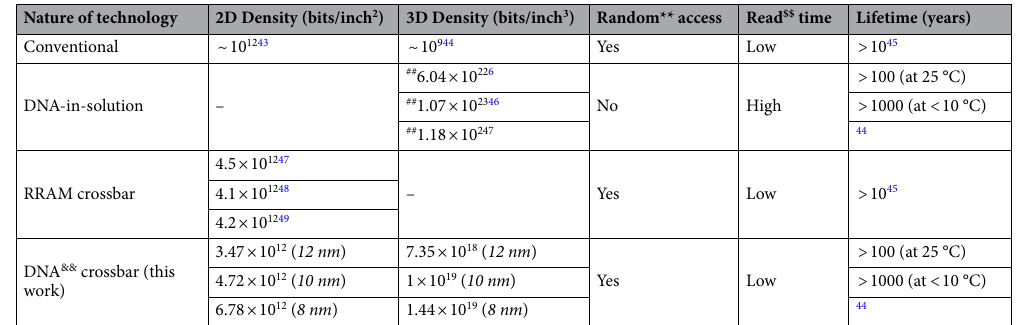
Table 1. Comparison of various storage technologies (existing and proposed). ## For 3D density of DNA-in- solution technology, bulk density is that of pure water. $$ Read time is classified to be ‘High’ if it is > 1 h and ‘Low’ if it is < 10 ns. && 2D and 3D density metrics for DNA crossbar storage are based on topological and DNA parameters. Italicized numbers (8 nm, 10 nm, 12 nm) refer to the half-pitch of the crossbar array.